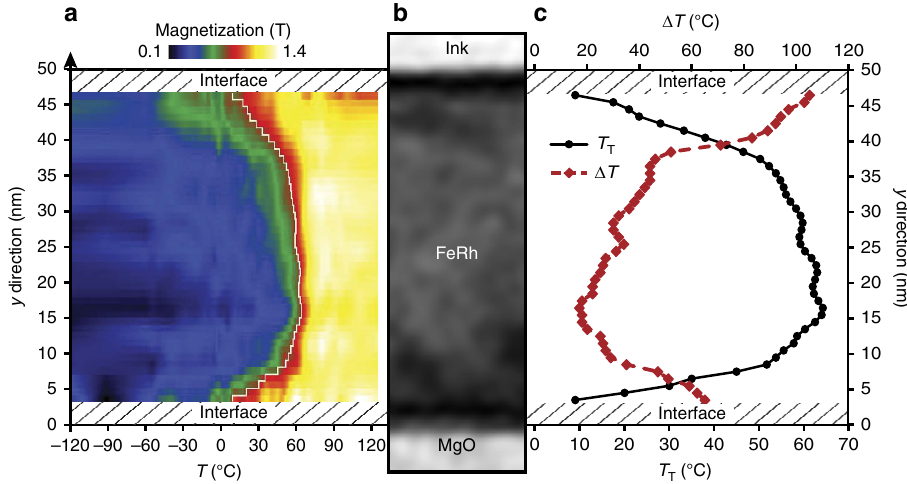
Figure 4 | Evolution of the magnetization in the growth direction. ( a ) Map of the magnetization as a function of the temperature and the position in the layer depth using the heating temperature series. The colour scale corresponds to the magnitude of the magnetization and the transition temperature is displayed by the white profile corresponding to magnetization of 0.75T. ( b ) Amplitude image of the part of the FeRh layer used for the calculation. ( c ) Profiles of the transition temperature T T and the transition width D T as a function of the position within the FeRh